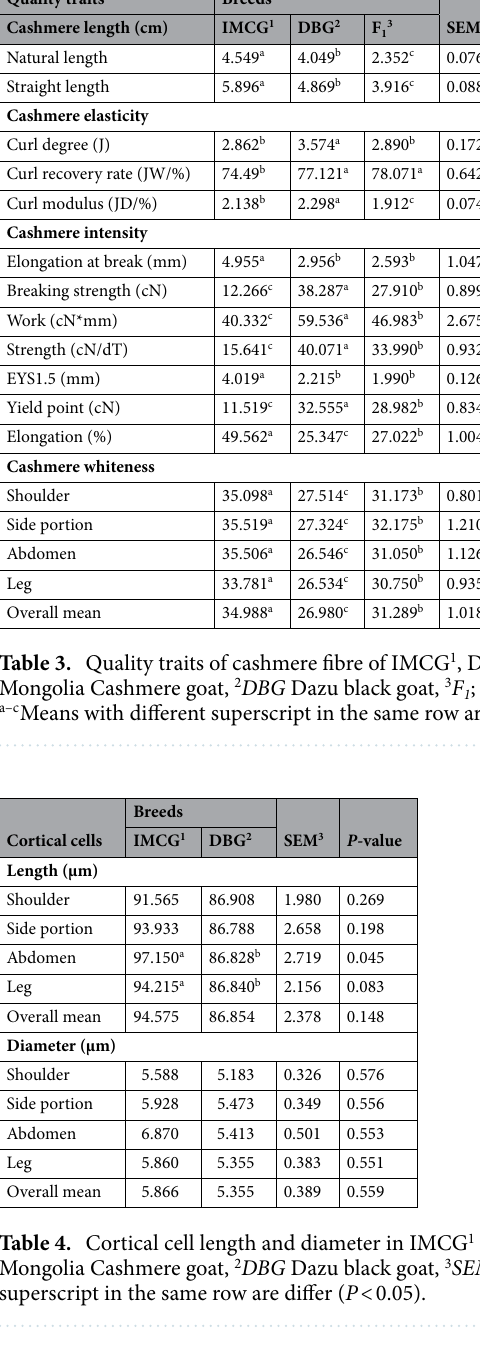
and diameter ( P = 0.543) among all body sites (Table 4). Figure 5 shows the cortical and stromal cells for both parents breeds. Coat colour. Three different colours were found in the studied goats; white, black and off white to light-brown for IMCG, DBG and F 1 , respectively (Figs. 6C and 7C, and Table 5). The coat colour of F 1 was very close to the IMCG parent. Hair/cashmere properties and their association with genetic variability. The genome of selected individuals from IMCG (n = 6) and DBG (n = 6) parents; previously sequenced by some of the current authors, averaged 6.02-folds coverage which produced raw data of 192.74 Giga base (Gb) then cleaned to reach 191.57 Gb, after filtration and quality check by removing the low-quality and paired reads. The two parents breeds contained 294 and 155 candidate regions, respectively. The top region was located on chromosome 2 of IMCG (113850001:113900001)